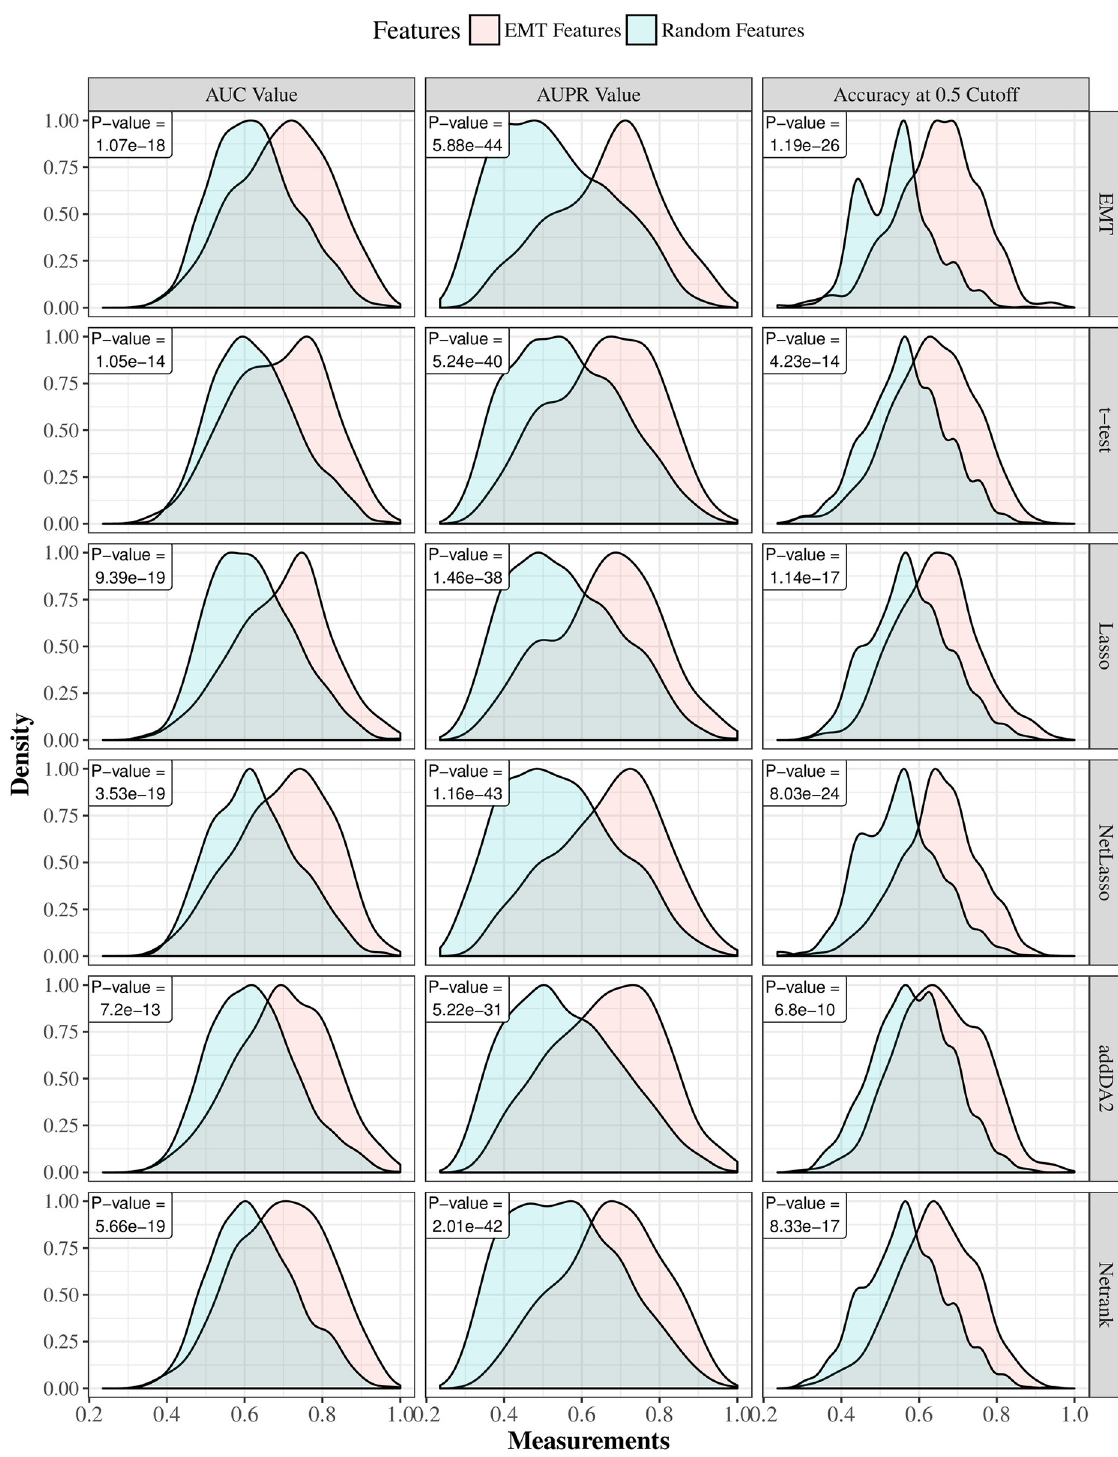
Fig 1. The AUC, AUPR, and accuracies of EMT features versus random features using DM data with the core EMT network. Gaussian kernel is used to estimate the density functions based on results from 30 times 10-fold cross-validation. For each cross-validation fold, EMT features and random features are tested on the same training and cross-validation samples. Each row in the figure corresponds to one feature selection algorithm. The last row corresponds to using all EMT features. The p-values of paired t-tests are provided in each sub-figure.